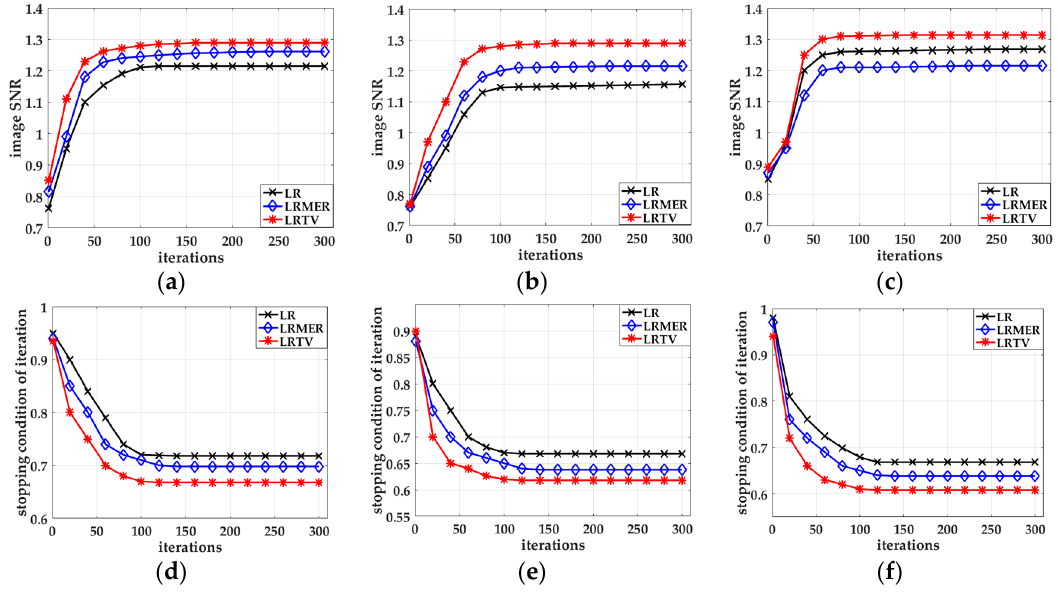
Figure 11. ( a ) Image SNR curve of LR, LRTER and LRTV when “hands prolapse”; ( b ) Image SNR curve of LR, LRTER and LRTV when “shoulder abduction”; ( c ) Image SNR curve of LR, LRTER and LRTV when “hands held”; ( d ) Termination condition of iteration of LR, LRTER and LRTV when “hands prolapse”; ( e ) Termination condition of iteration of LR, LRTER and LRTV when “shoulder abduction”; ( f ) Termination condition of LR, LRTER and LRTV when “hands held”.